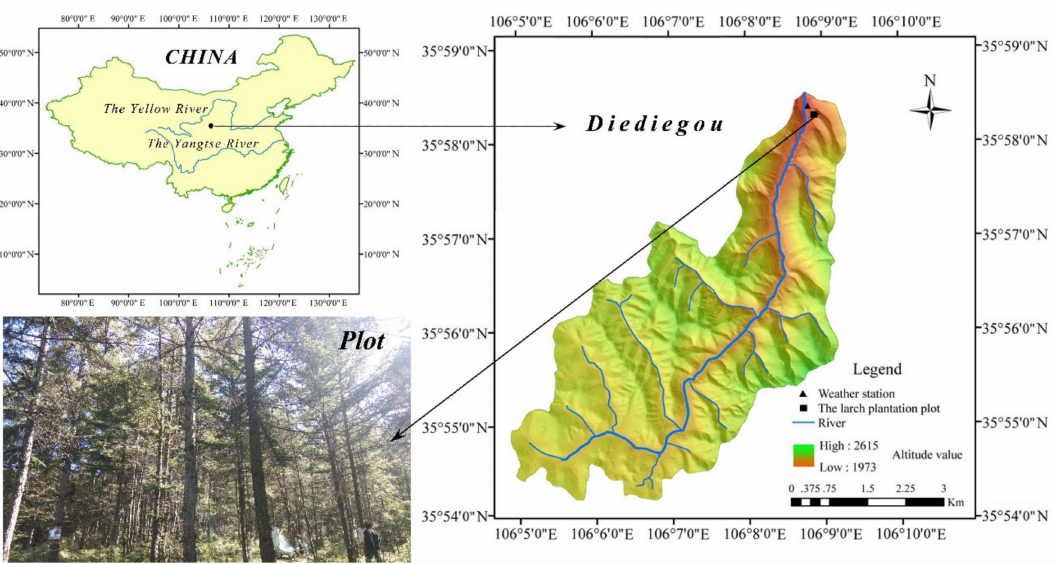
Figure 1. Locations of the study site (Diediegou), weather station, and the larch plantation plot (modified based on Li et al. [35]).